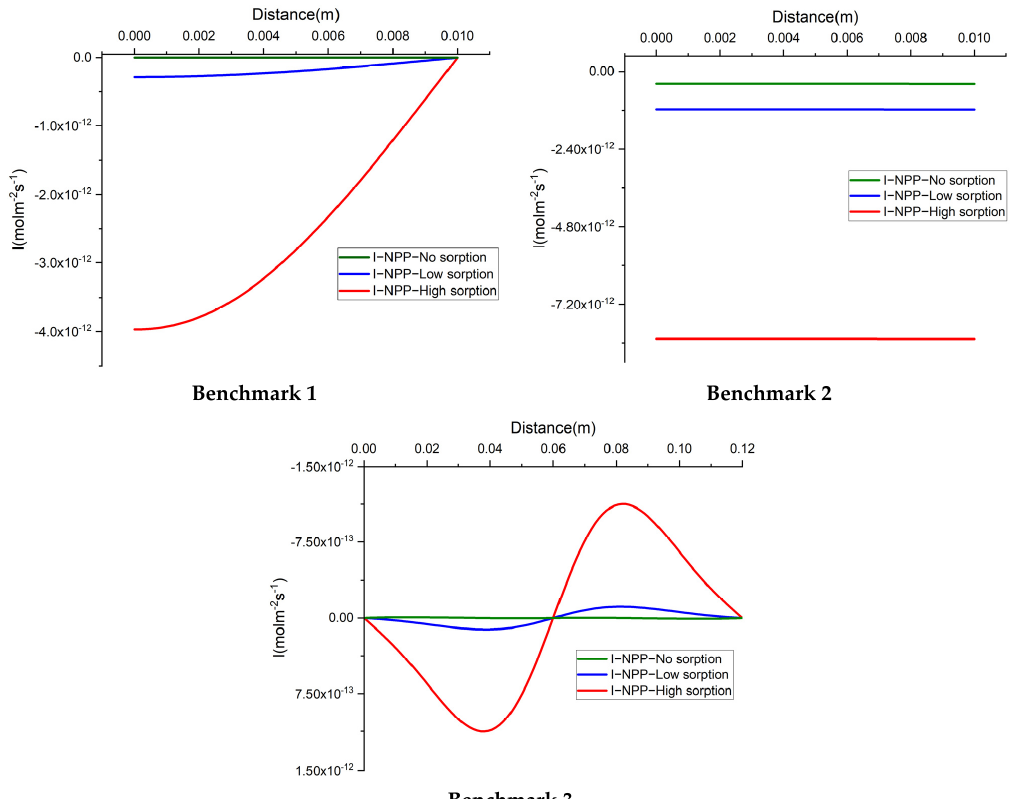
Figure 6. The total electrical current for the 1D benchmarks with the NPP and NC-models.